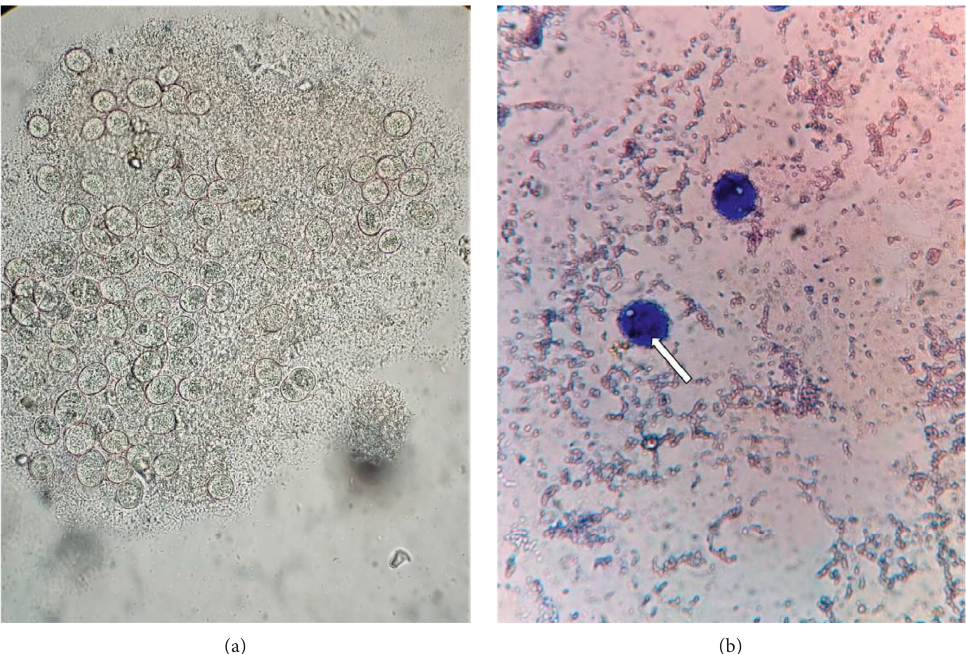
Figure 1: (a) Cysts and trophozoite of Balantidium coli (wet mount: original magnification 100 × ). (b) Trophozoite showing macronucleus and vacuole at the centre and cilia on outer cell wall (trichrome staining); original magnification 400 ×